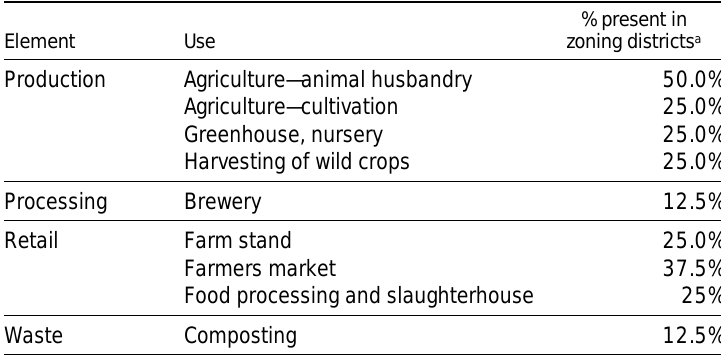
Table 9. Gays Mills Districts and Uses